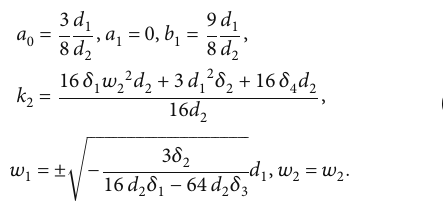
Figure 6: The graphical simulation representation of j U 3 0 : 1, δ = 0 : 6 4